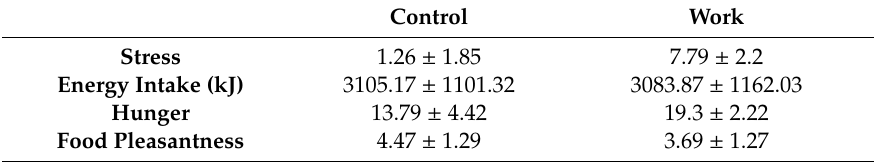
Figure 3. Normalized energy intake under control and work conditions. Significant di ff erence was observed at the *: 5% level. Table 4. Descriptive results on outcome variables (results expressed as mean ±